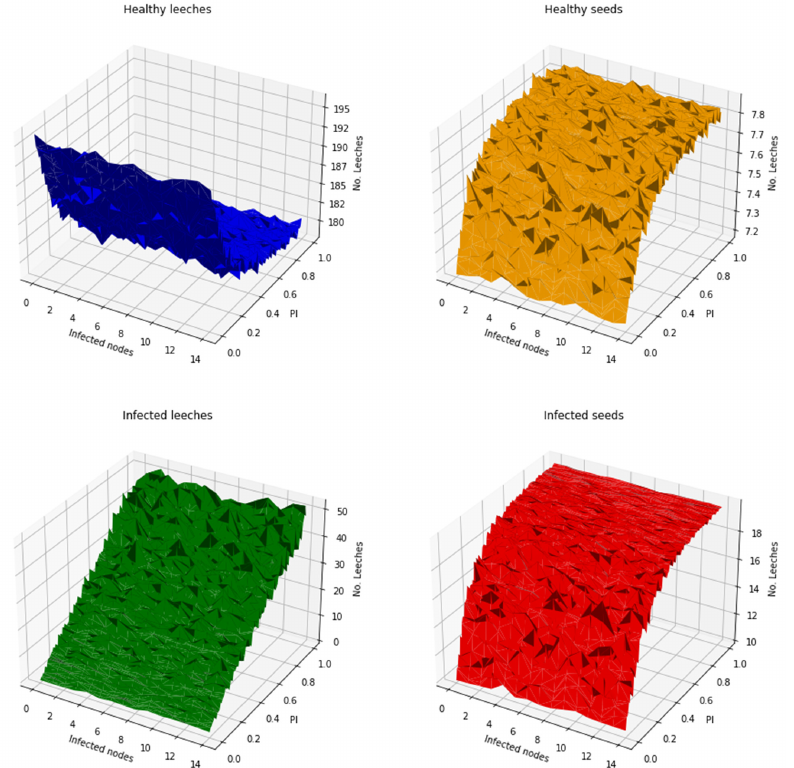
Figure 11. Average number of healthy and infected nodes for different numbers of initial malicious nodes, Ni, and efficiency of the countermeasures,